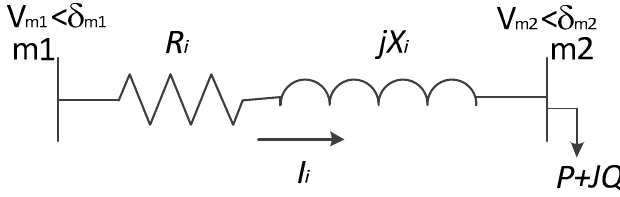
Figure 1. One-line diagram of two-bus radial distribution system .